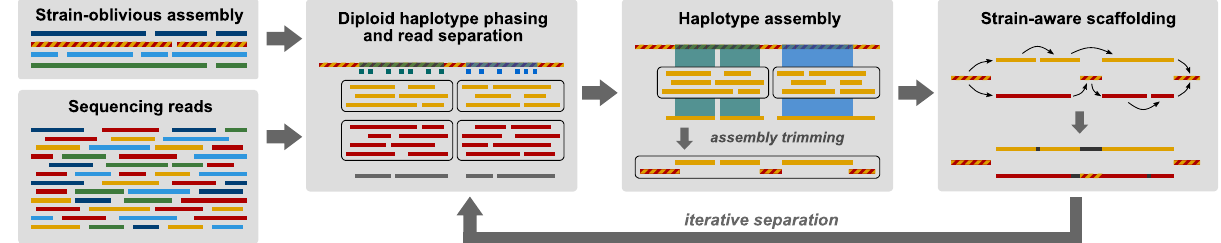
Fig. 1 Strainberry pipeline. The pipeline starts from a strain-oblivious assembly and the corresponding set of reads. It then performs haplotype phasing on the strain-oblivious assembly to separate reads into groups that likely correspond to strains. Each group is assembled separately. A fi nal scaffolding step is used to connect sequences likely corresponding to the same strain. The pipeline performs n (cid:1) 1 iterations, where n is the maximal number of